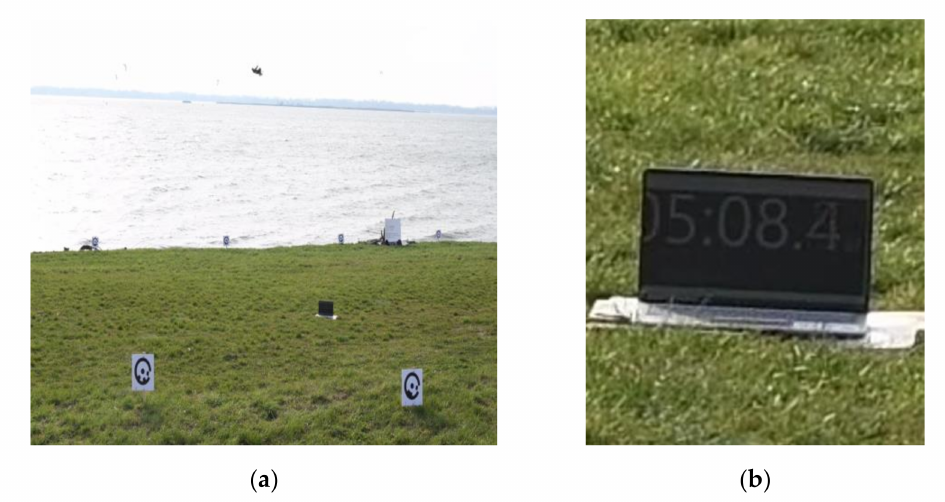
Figure 3. ( a ) Sample field of view from camera 3; ( b ) Detail with the laptop timer. The kiter attempted to perform the jumps as close to the shore as possible. The distance between the cameras and the place of the jump was approximately 45–120 m. The primary benefit of using four cameras was the extended lateral coverage of the water surface, as the jumper had to be visible from at least two camera positions for evaluation. In addition, each additional projection increased the reliability of the evaluated 3D coordinates of the observed marks. There were two motivations for placing two contrasting marks on the twintip board: (1) to calculate the average board position based on the positions